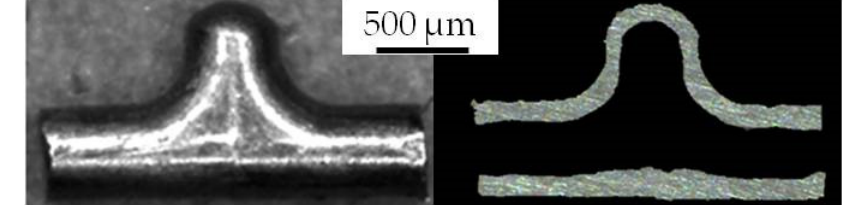
Figure 12. Appearance and axial cross-section of T-shape sample of SUS304 ( p h = 70 MPa, ∆ L = 750 µ m).